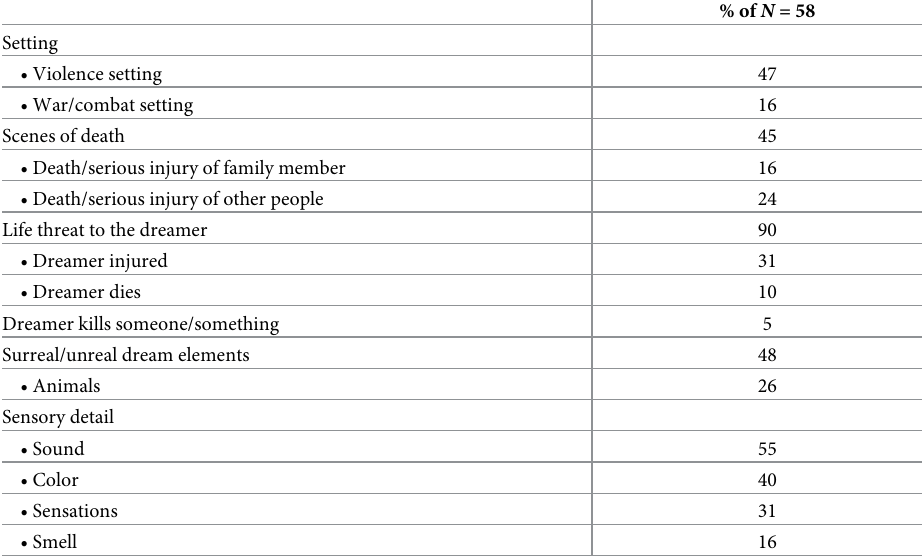
Table 1. Nightmare characteristics among war-affected